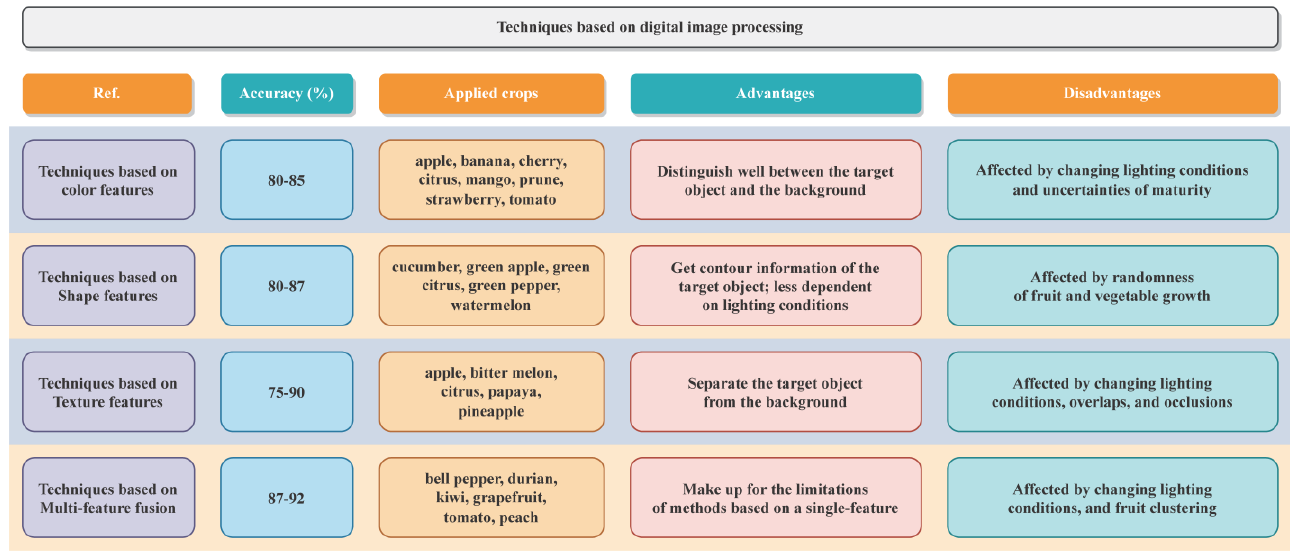
Figure 5. Techniques based on digital image processing.